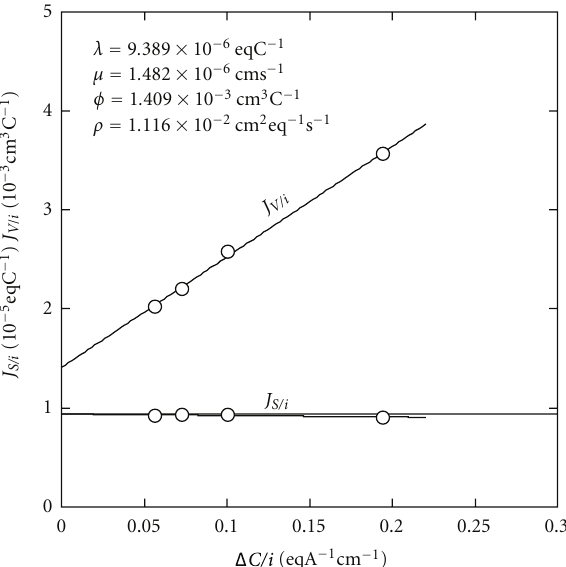
Figure 3: J S /i versus Δ C/i plot and J V /i versus Δ C/i plot. Selemion CMR/ASR 25 ◦ C.